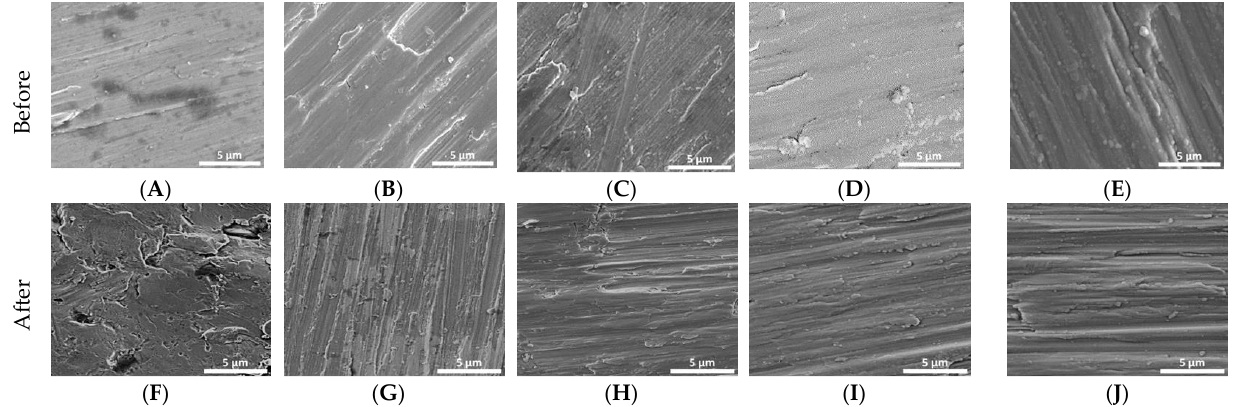
Figure 1. Initial SEM images of Ti disks non-coated and coated ( A – E ). SEM images of Ti disks non-coated and coated after 30 days in cultivation of P. gingivalis , S. mutans , S. salivarius , and S. sanguinis ( F – J ). ( A , F )—non-coated; ( B , G )—coated with titanium nitride (TiN); ( C , H )—coated with quarternized titanium nitride coated titanium (QTiN), ( D , I )—coated with silicon carbide (SiC), and ( E , J )—coated with quaternized SiC (QSiC).